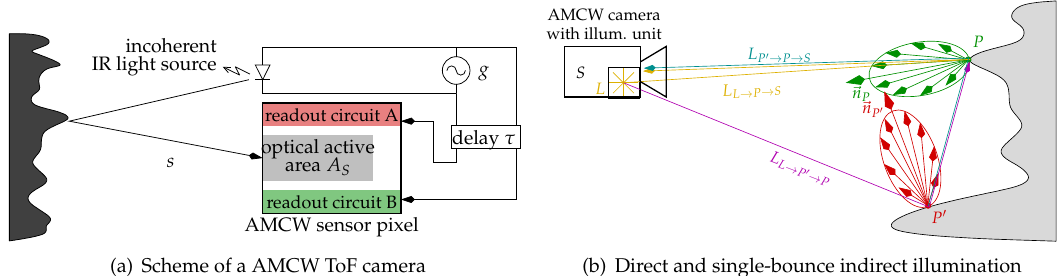
Figure 1. Scheme of a AMCW ToF camera including the pixel layout and the optically active pixel area A S (gray) with the two readout circuits A (red) and B (green) ( a ); direct illumination and one path of single-bounce indirect illumination in the AMCW ToF simulation ( b ).